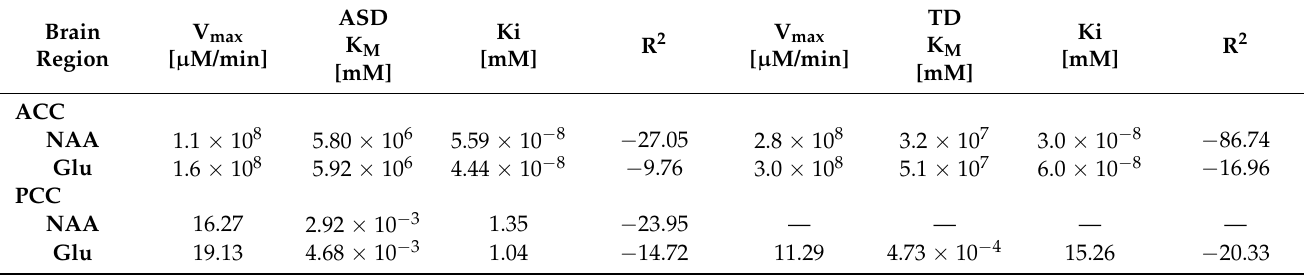
Table 8. Parameters for the expression of the biosynthesis of N -acetylaspartyl-glutamate in the substrate inhibition model of Michaelis–Menten by proton magnetic resonance spectroscopy ( 1 H-MRS) in the ASD ( n = 22) and TD ( n = 43) groups. Brain